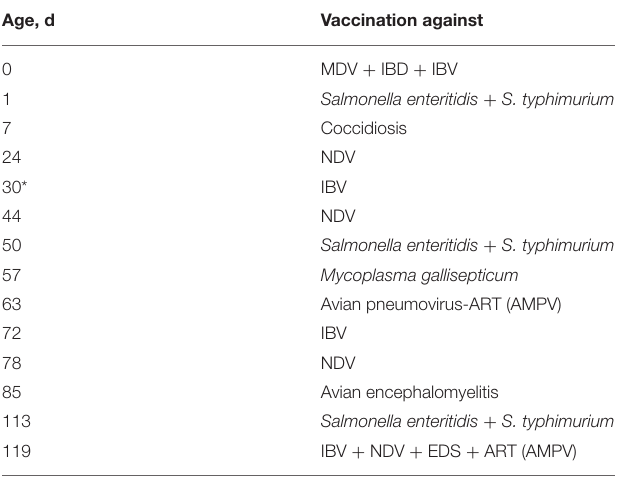
TABLE 1 | Summary of the conventional vaccination program applied to Lohmann Brown Plus and Lohmann Dual hens during growing period (17 weeks). Age,